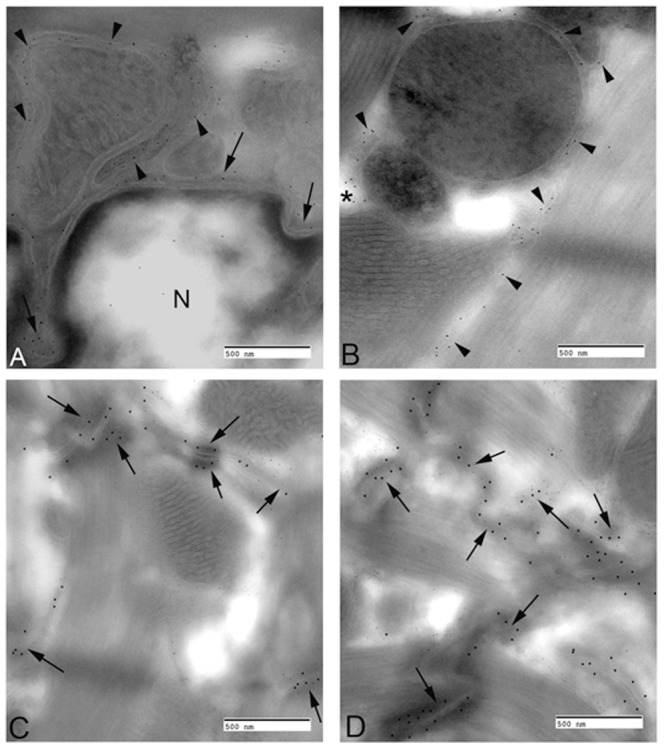
Expression of IC disc proteins in HL-1 cells transfected with wild-type and mutant TMEM43.
A and B. The stably transfected cells were lysed and Western blot was performed for ZO-1, α-catenin, N-cadherin, β-catenin, JUP, Cx43 and GAPDH. The expression of α-catenin, N-cadherin, β-catenin and JUP were similar in non-transfected HL-1 (control) and stably-transfected cells (TMEM43-WT and TMEM43-S358L). A. The level of ZO-1 was significantly decreased in TMEM43-S358L cells compared to TMEM43-WT and control. B. P2 and P0 represent the phosphorylated and non-phosphorylated forms of Cx43. The level of the non-phosphorylated Cx43 isoform (P0) was increased in mutant cells compared to the control and TMEM43-WT cells. C and D. Densitometry analysis of ZO-1/GAPDH and phosphorylated Cx43 P2/P0. * denotes p<0.05. The densitometry results showed the combined analysis of three separate western blots and the western blot images are representative of three independent cell culture experiments.